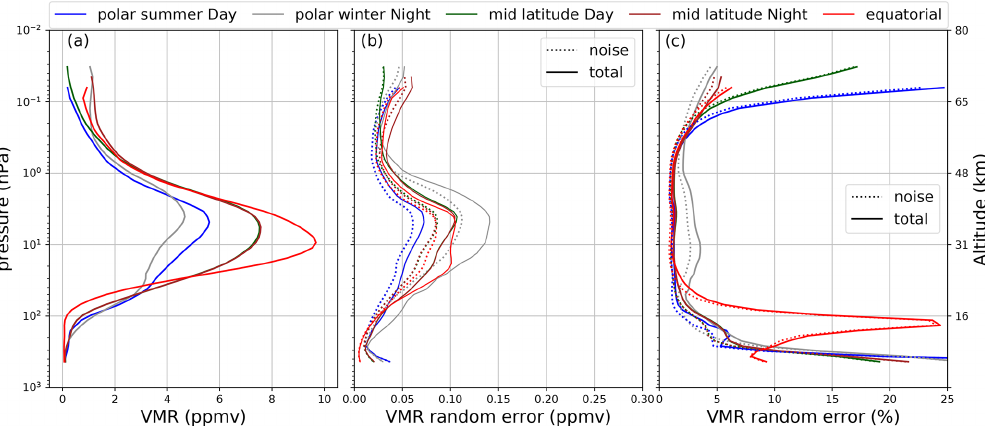
Figure 3. Ozone VMR for several conditions (a) , absolute (b) , and relative (c) random error for the full resolution (FR) nominal mode averaged over 2003. The dotted lines represent the average noise error; the solid lines represent the total random error, coming from the quadratic summation of the noise error and the p,T propagation error.